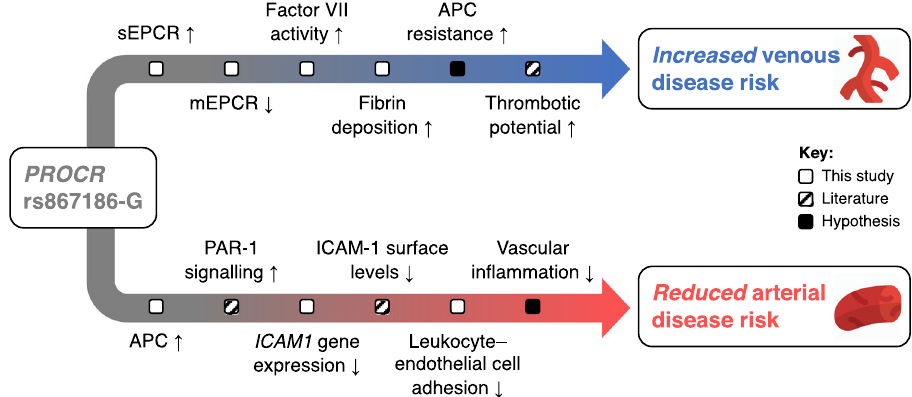
Fig. 6 Proposed molecular mechanism underlying the PROCR -p.S219G variant. Credits: Icons were made by Pixel perfect from https://www. fl